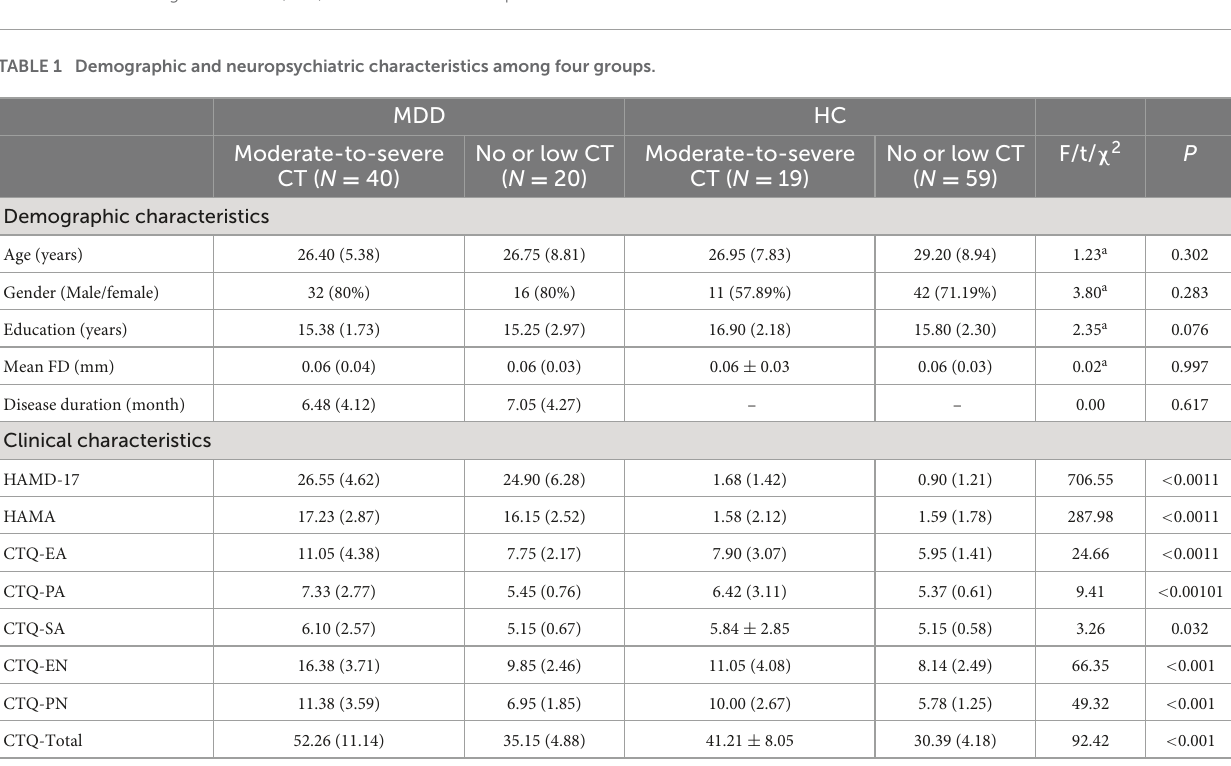
FIGURE1 The map of five ACC subregions in each hemisphere. Five seeds for left and right hemisphere to represent different ACC functional subdivisions, including caudal ACC (L/R-Sl, blue, MNI = ± 5, − 10, 37), dorsal ACC (L/R-S2, peacock blue, MNI = ± 5, 10, 33), rostral ACC (L/R-S3, green, MNI = ± 5, 27, 21), perigenual ACC (L/R-S4, orange, MNI = ± 5, 47, 11), and subgenual ACC (L/R-S5, red, MNI = ± 5, 34, − 4). All these seeds were defined in the Montreal Neurological Institute (MNI) coordinates with the spheres of 4 mm.